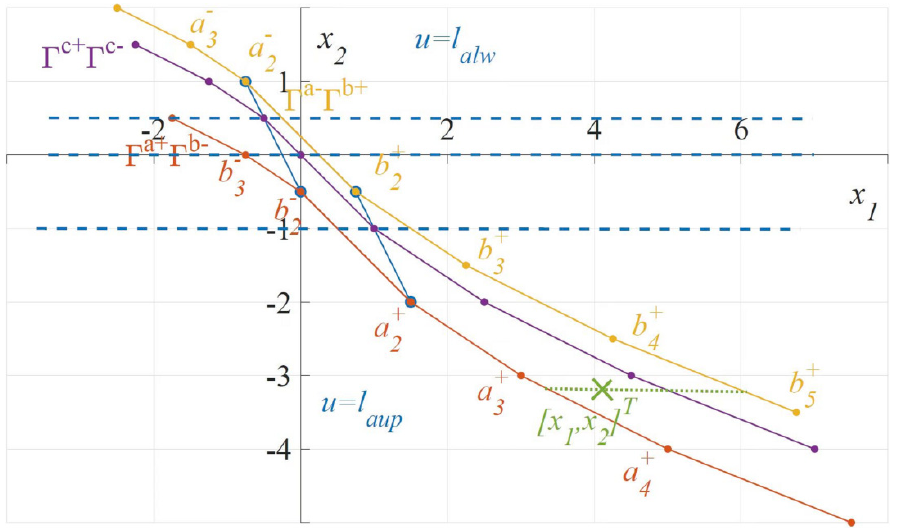
Figure 5. Diagram of phase plane partitions. Reprinted with permission from refs. [16,17]. Denote the shortest distance between the point p and the polyline Γ as dist ( p , Γ ) , the control quantity u would have the following characteristics when the starting point is between the two polylines Γ a + Γ b − , Γ a − Γ b + .